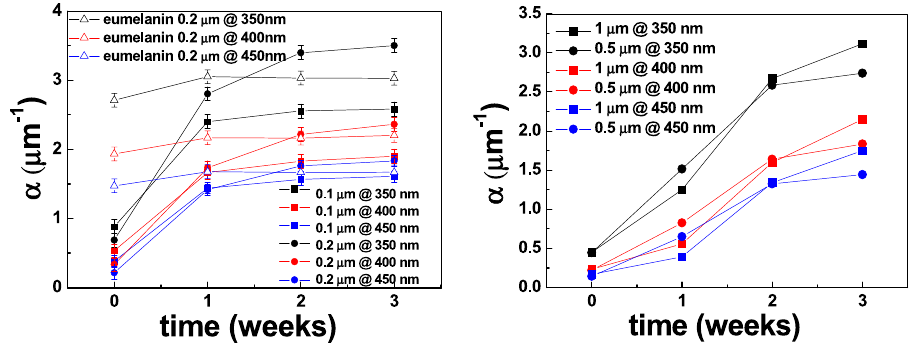
Figure 2. Absorption coefficient of the films as a function of aging time at different wavelengths, namely 350 nm, 400 nm and 450 nm: (left) DHI thin films of 0.1 μ m and 0.2 μ m undergoing SSSP, and the 0.2 μ m DHI films subjected to AISSP; (right) DHI thin films of 0.5 μ m and 1 μ m.